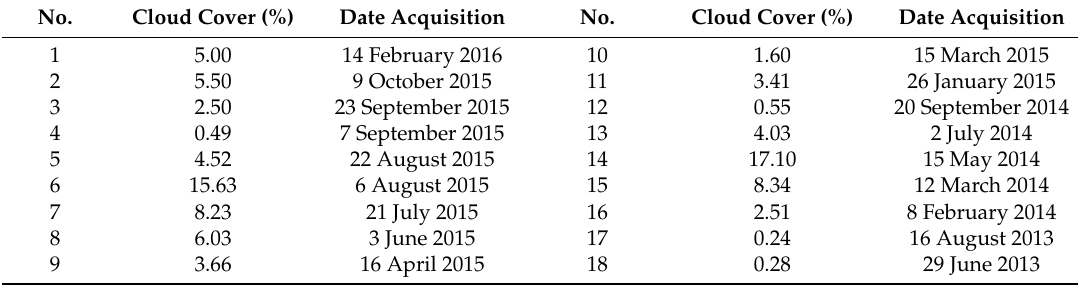
Table 2. Date acquisition and cloud cover (%) of Landsat 8 OLI images